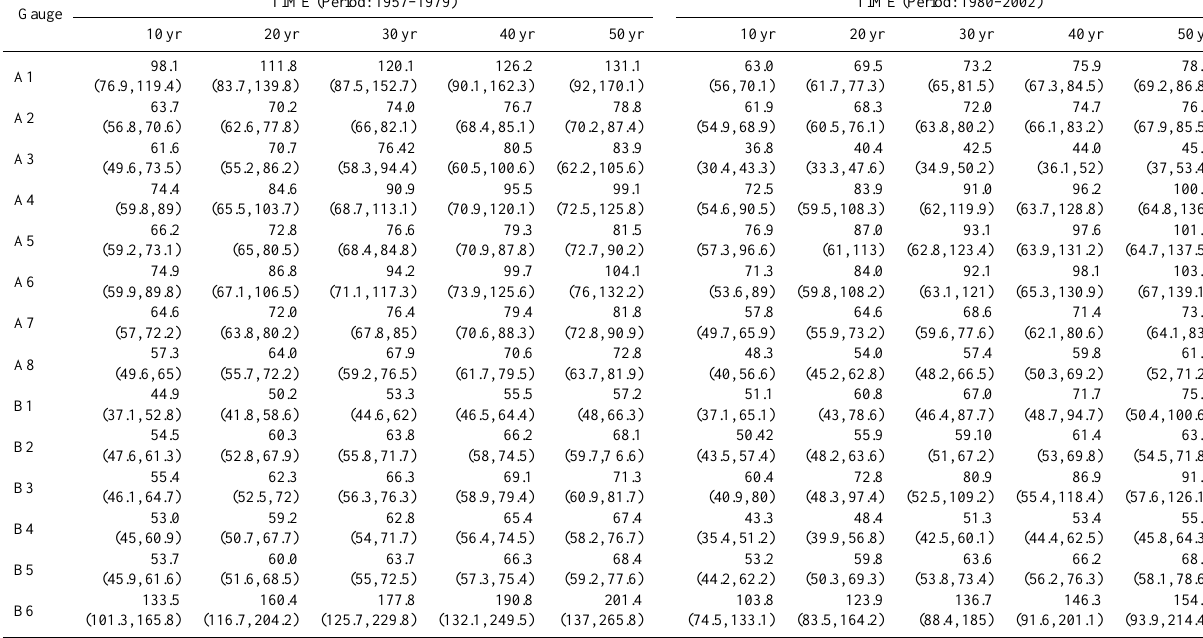
Table 6. Estimated return rainfall levels (mmday − 1 ) and their 95% confidence intervals for selected return times in years, by delta method.